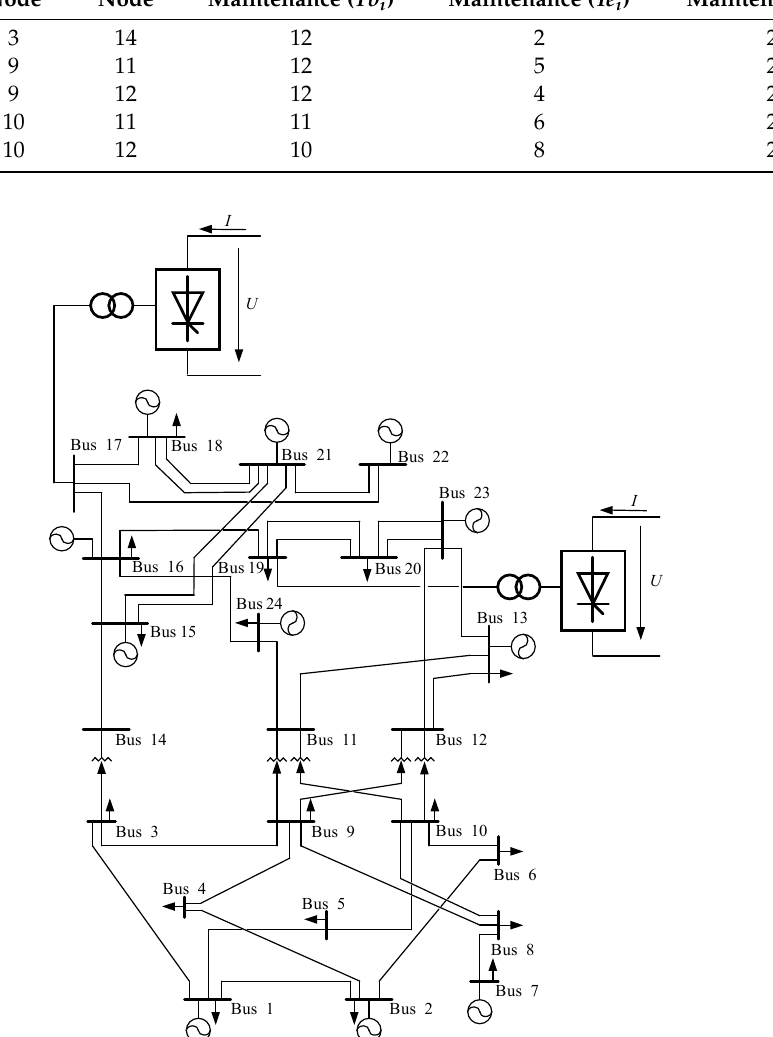
Figure 1. Improved IEEE reliability test 79 system.